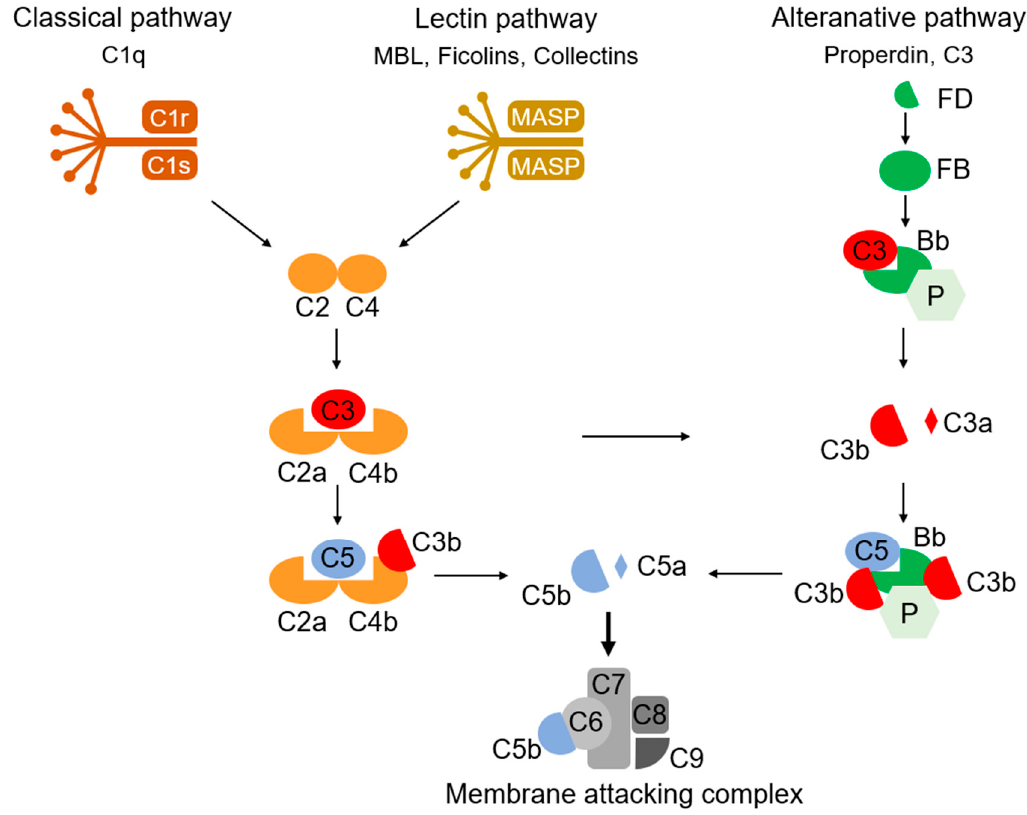
Figure 1. An overview of systemic complement activation. The complement system is composed of nine main components (C1–C9) and regulatory factors. Immunological functions are conducted by three pathways: the classical, alternative, and lectin pathways. In these pathways, enzymatic chain reactions of the complements proceed to finally form a membrane attack complex to destroy bacteria and virus-infected cells. MASP, mannose-binding protein-associated serine protease; FD, factor D; FB, factor B; Bb, factor Bb; P, properdin.